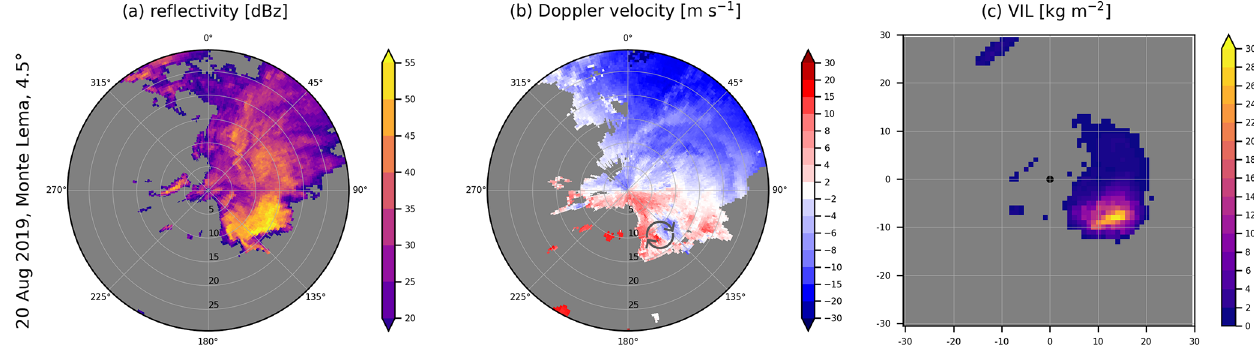
Figure 2. Example of a supercell in the Southern Prealps; 20 August 2019 at 17:30UTC.